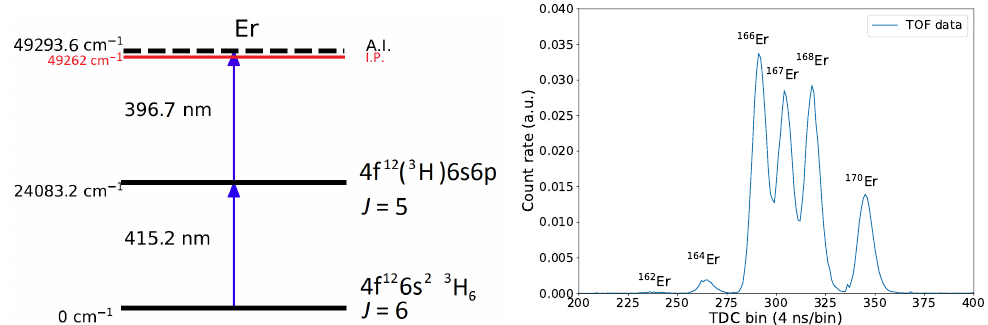
Figure 7. ( Left ) Er I two-step ionization scheme used for NB RIS measurements [32]. On the left hand side of the diagram, the excited state, the ionization potential (I.P.) energy and the populated auto-ionizing (A.I.) state levels are presented, on the right hand side, electron configuration and total angular momentum J are shown. ( Right ) TOF spectrum of the Er ions observed with the NB Ti:sa system using the scheme shown in the left